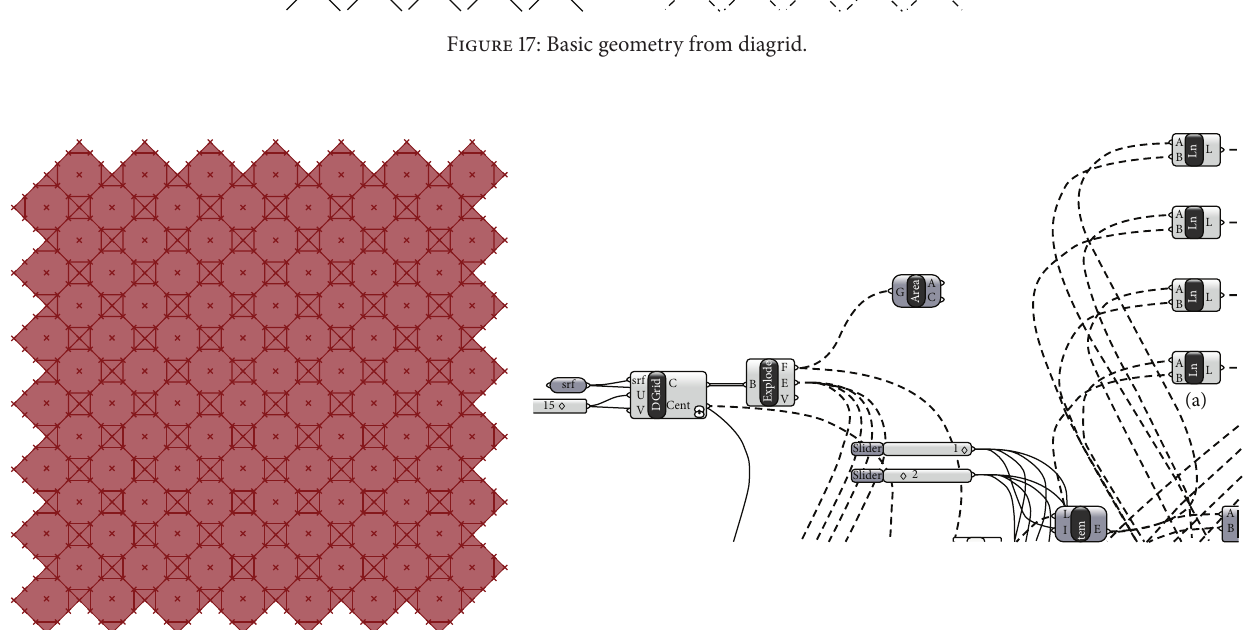
Figure 18: Algorithmic